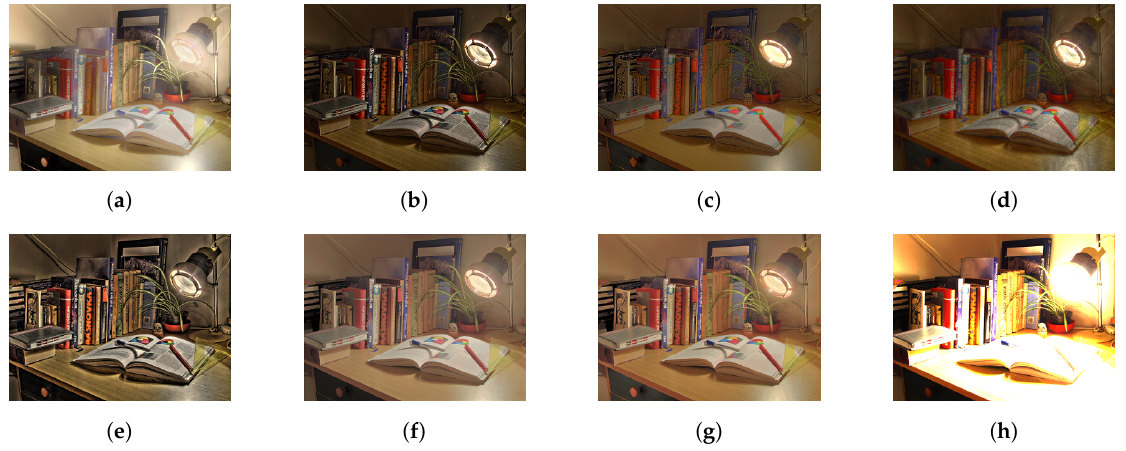
Figure 8. Comparison of tone-mapping methods. ( a ) LW [12], ( b ) WLS [28], ( c ) RoG [2], ( d ) L0